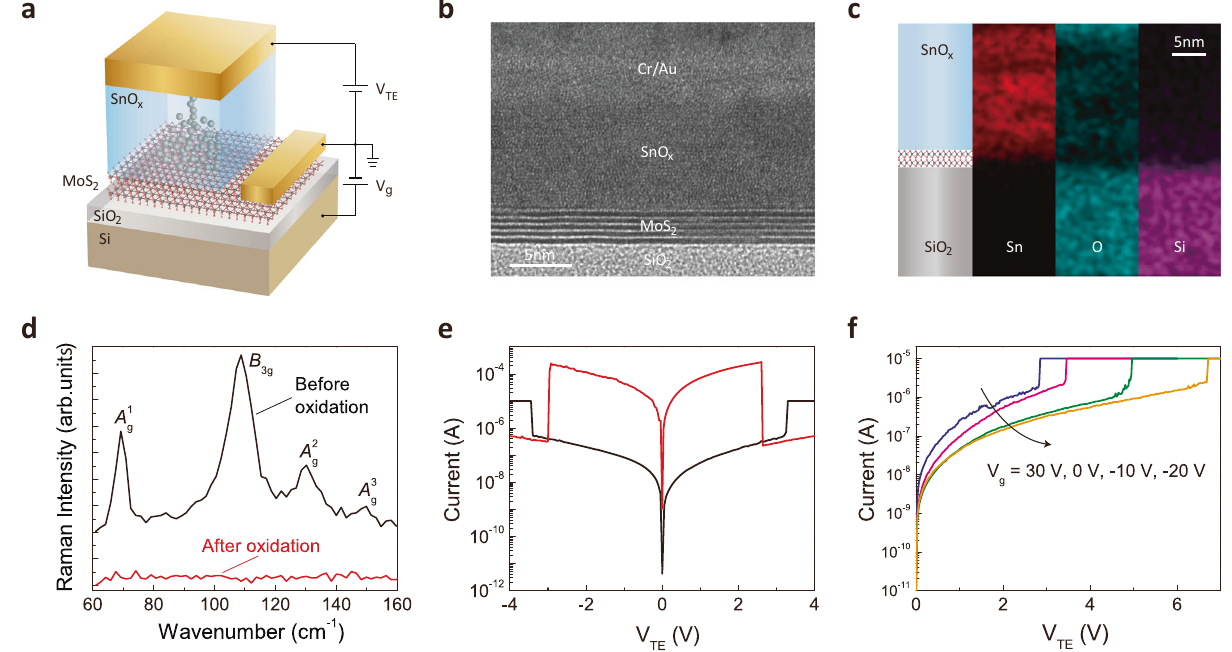
Fig. 1 Device structure and electrical characteristics. a Schematic of the heteromemristive device. b The HR-STEM image of the fabricated device cross section. The scale bar is 5 nm. c EDX scan indicates the elemental composition. d Raman spectra for the SnSe sample before and after oxidation. The missing-signature modes after oxidation indicate the full oxidation and amorphization of the SnSe sample. e Unipolar electrical switching characteristics of the device at V g = 0 V. The set and reset voltages in positive scan are 3.2 V and 2.8 V, and in negative scan are − 3.4 V and − 3 V. f Modulation of the set voltage by the gate bias. When V g decreases from 30 V to − 20 V, the set voltage